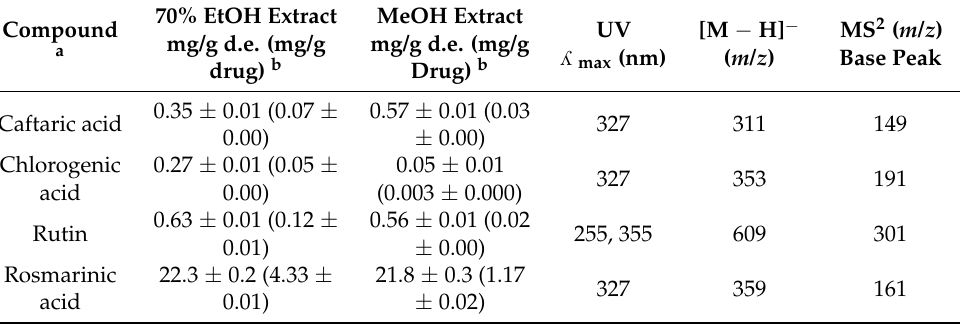
Table 2. Main constituents identified in extracts of O. campechianum by HPLC-DAD, high- performance liquid chromatography/electrospray ionization mass spectrometry (HPLC-ESI-MS), and MS 2.